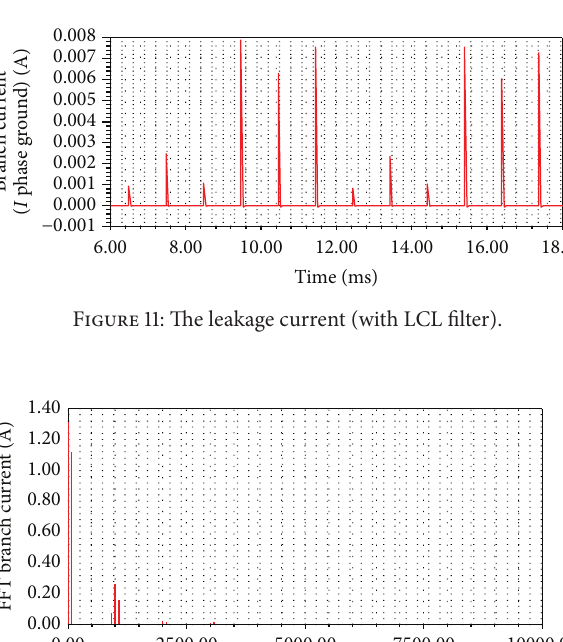
Figure 14: The equivalent circuit of the motor by the capacitor